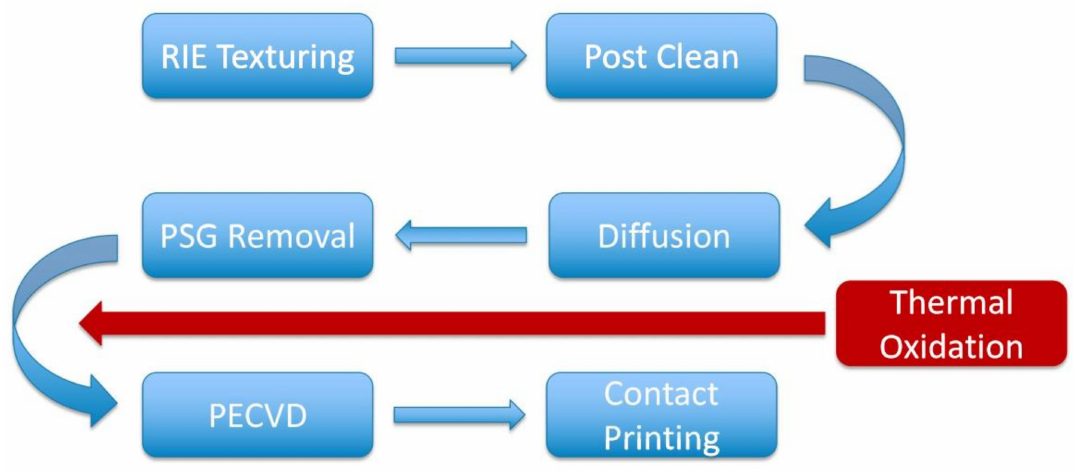
Figure 3. The manufacturing process of the c-Si PV cell and the addition location of thermal